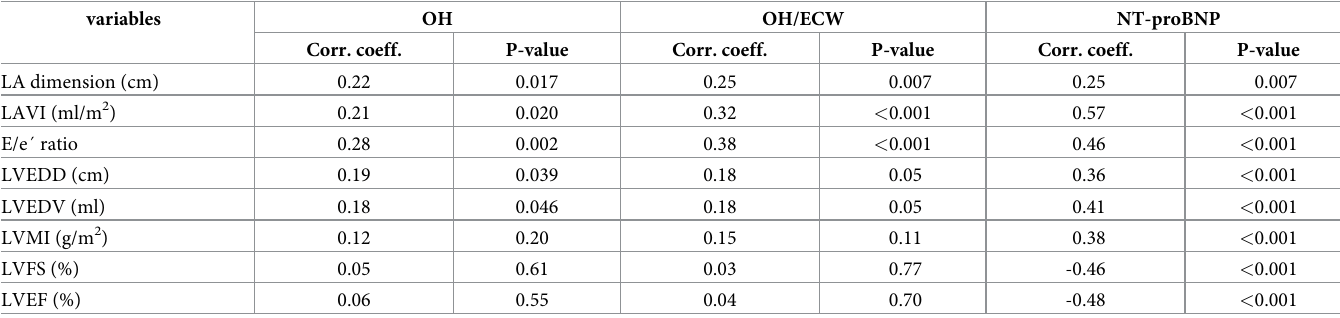
Table 3. Correlation of OH, OH/ECW, and NT-pro BNP with echocardiographic parameters.